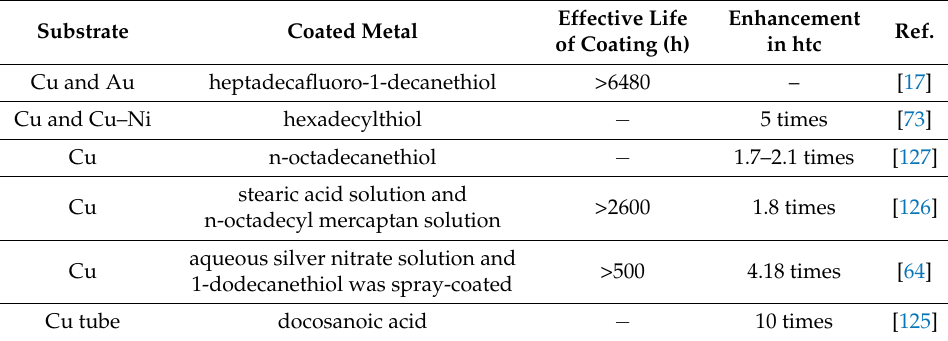
Figure 9. Working principal of self-assembled monolayers (SAMs) showing the fundamental blocks. Table 4. Steam condensation enhancements by SAM coatings.